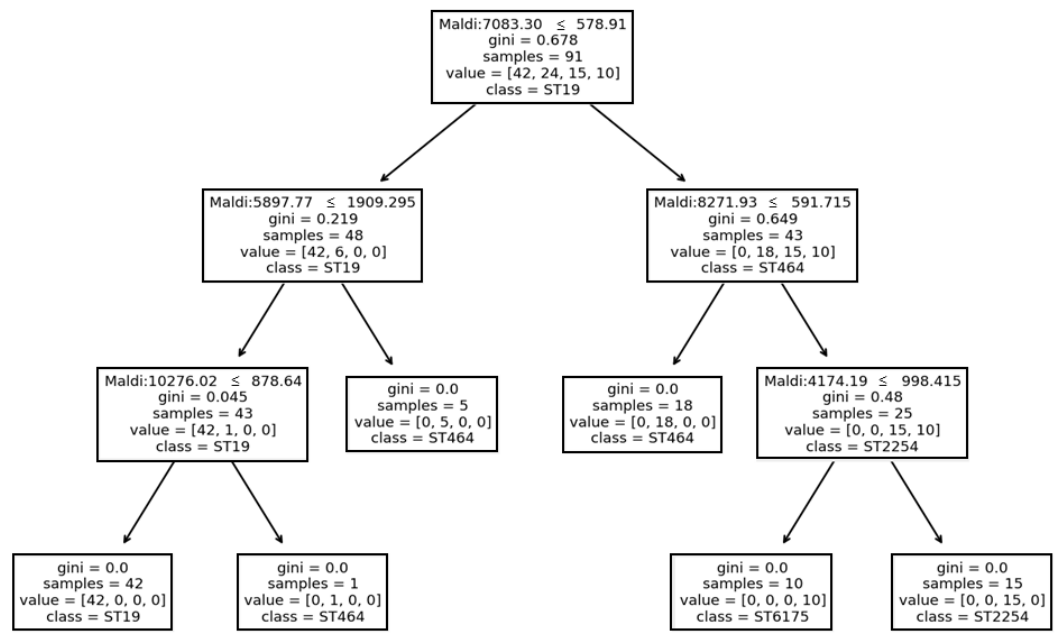
Figure 3. Decision tree trained on the peak matching table with intensity values from the complete dataset ( n = 91 MSPs) grouped by their ST profiles. Maldi: peak feature; Gini: measures the probability of misclassifying an observation; samples: illustrates how many samples the node contains; value: refers to how many samples at the node fall into each ST